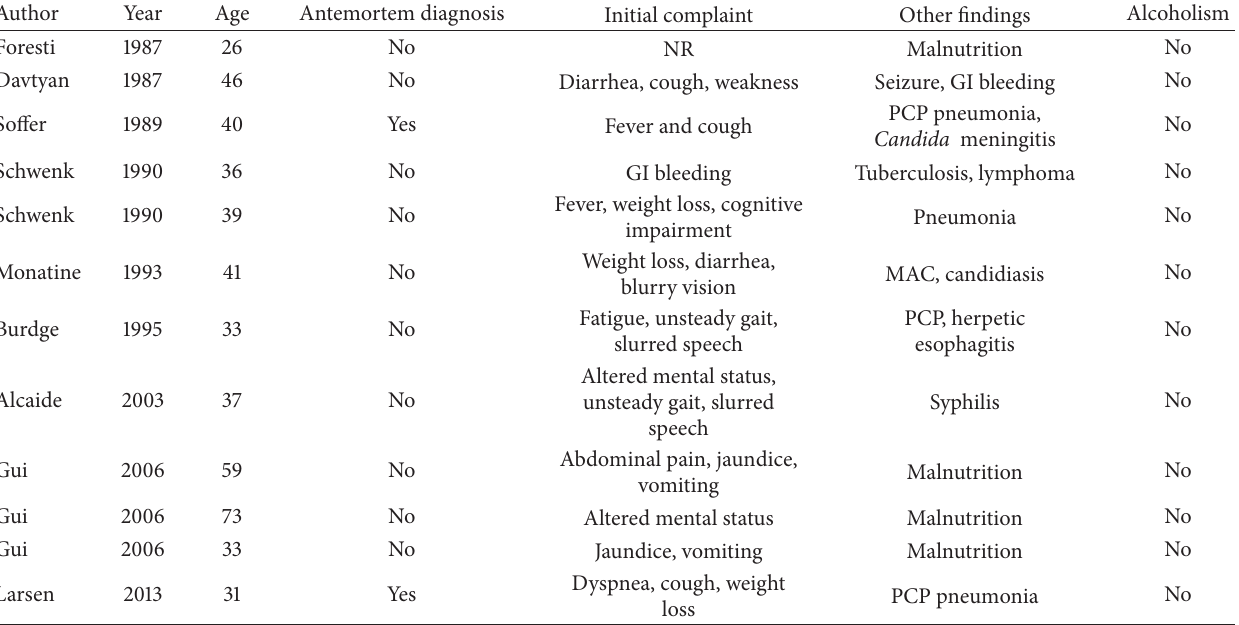
Table 1: Reported cases of Wernicke’s